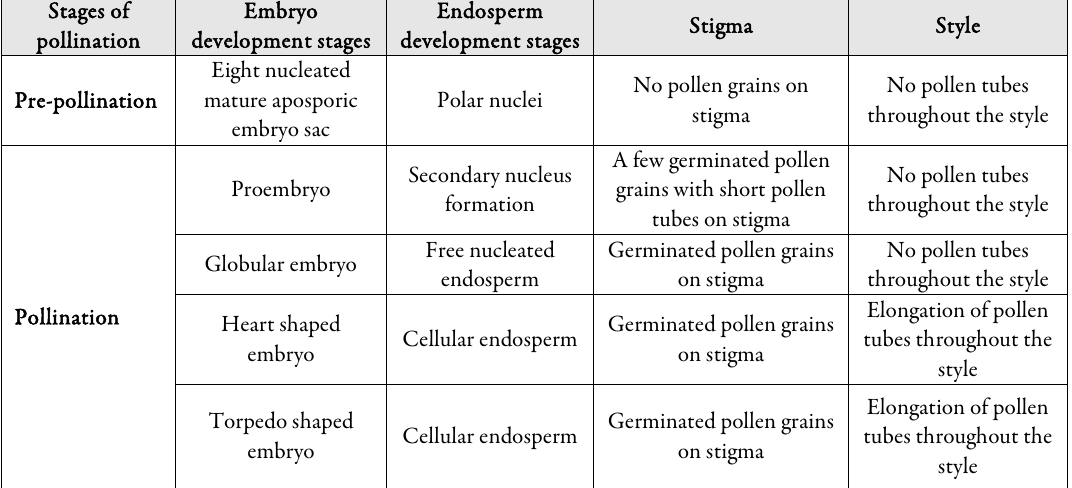
Figure 3. Embryo and endosperm formation in C. tanacetifolia a Eight nucleated mature aposporic embryo sac, b Aniline Blue stained stigma of the flower containing mature aposporic embryo sac, c DAPI stained proembryo, d DAPI stained Secondary nucleus, e Aniline Blue stained stigma of flower containing proembryo and seconder nucleus, f Globular embryo, g Free nucleated endosperm, h Aniline Blue stained stigma of flower containing globular embryo and free nucleated endosperm, i Heart shaped embryo and cellular endosperm, j Aniline Blue stained stigma of flower containing heart shaped embryo and cellular endosperm. PN: Polar nuclei, SYN: Synergid cell, STG: Stigma, PRE: Proembryo, CC: Central cell, STL: Style, GE: Globular embryo, FNE: Free nucleated endoperm, CE: Cellular endosperm, HE: Heart shaped embryo. Bar:10 µm (d), 50 µm (a, b, c, e, j, f, g, h, i). Table 2. The comparison of embryo and endosperm formation with the different stages of pollination in C.